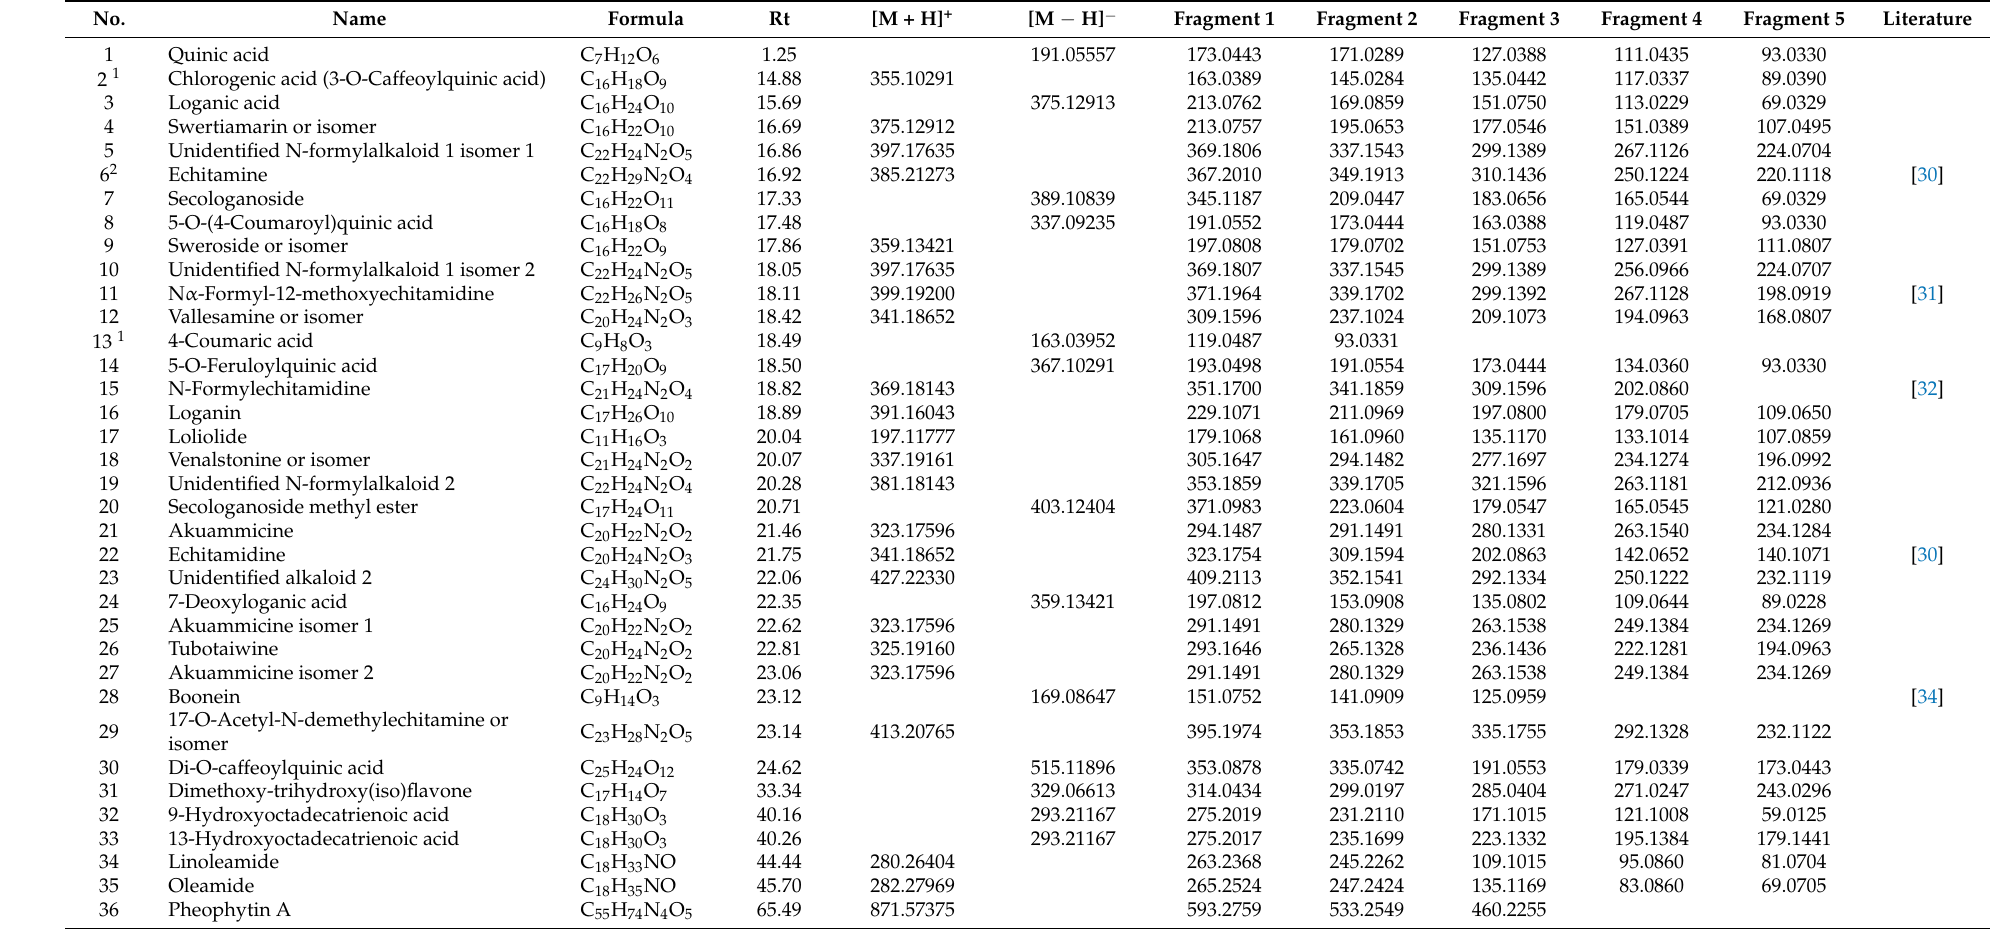
Table 7. Chemical characterization of stem bark—MAC-MEOH (not